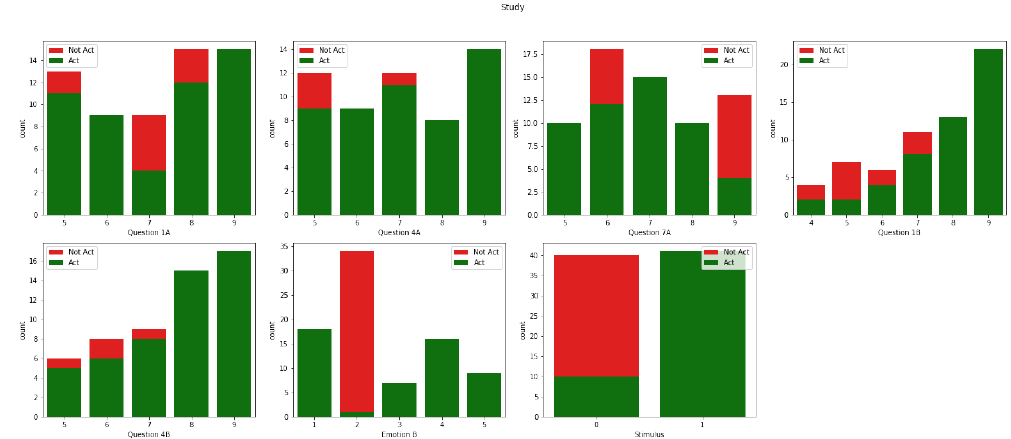
Figure 4. Frequencies of